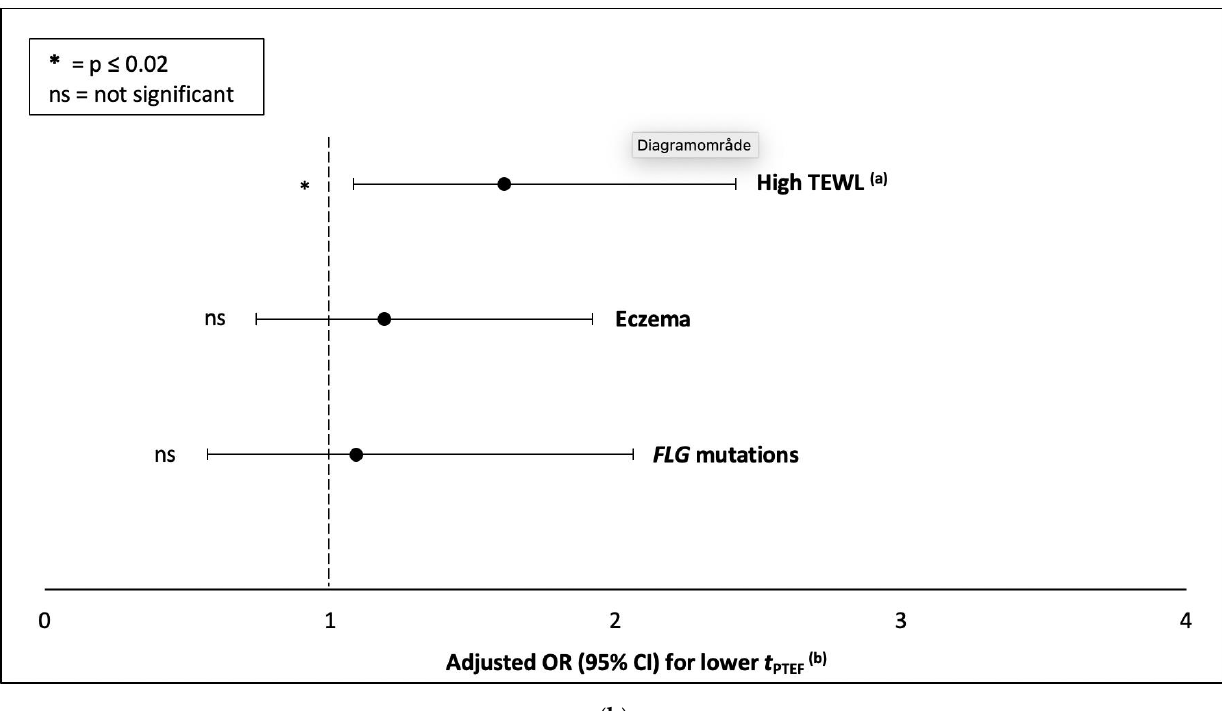
Figure 2. ( a , b ). Adjusted OR (95% CI) for lower t PTEF / t E ( a ) and t PTEF ( b ), according to the presence of high TEWL, eczema or FLG mutations in the 899 three-month-old infants. (a) High TEWL equal to a mean TEWL >8.83 g/m 2 /h (>75th percentile) (b) Lower t PTEF / t E and t PTEF equal to a t PTEF / t E <0.25 and a t PTEF <0.17 s (<25th percentile), respectively.